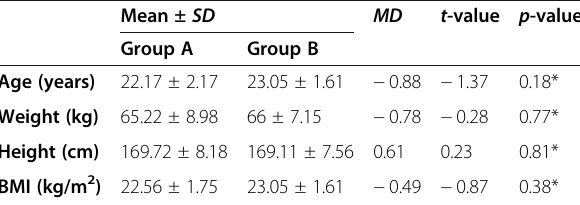
Table 1 Comparison of characteristics of participants between group A and group